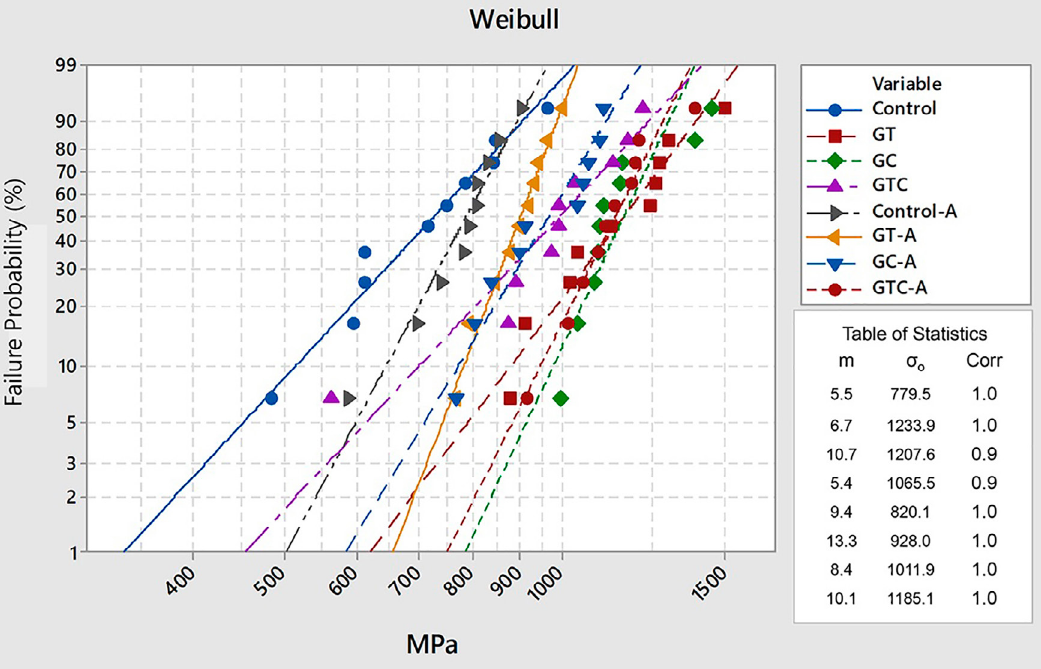
Figure 2- Weibull plot for biaxial flexure strength of